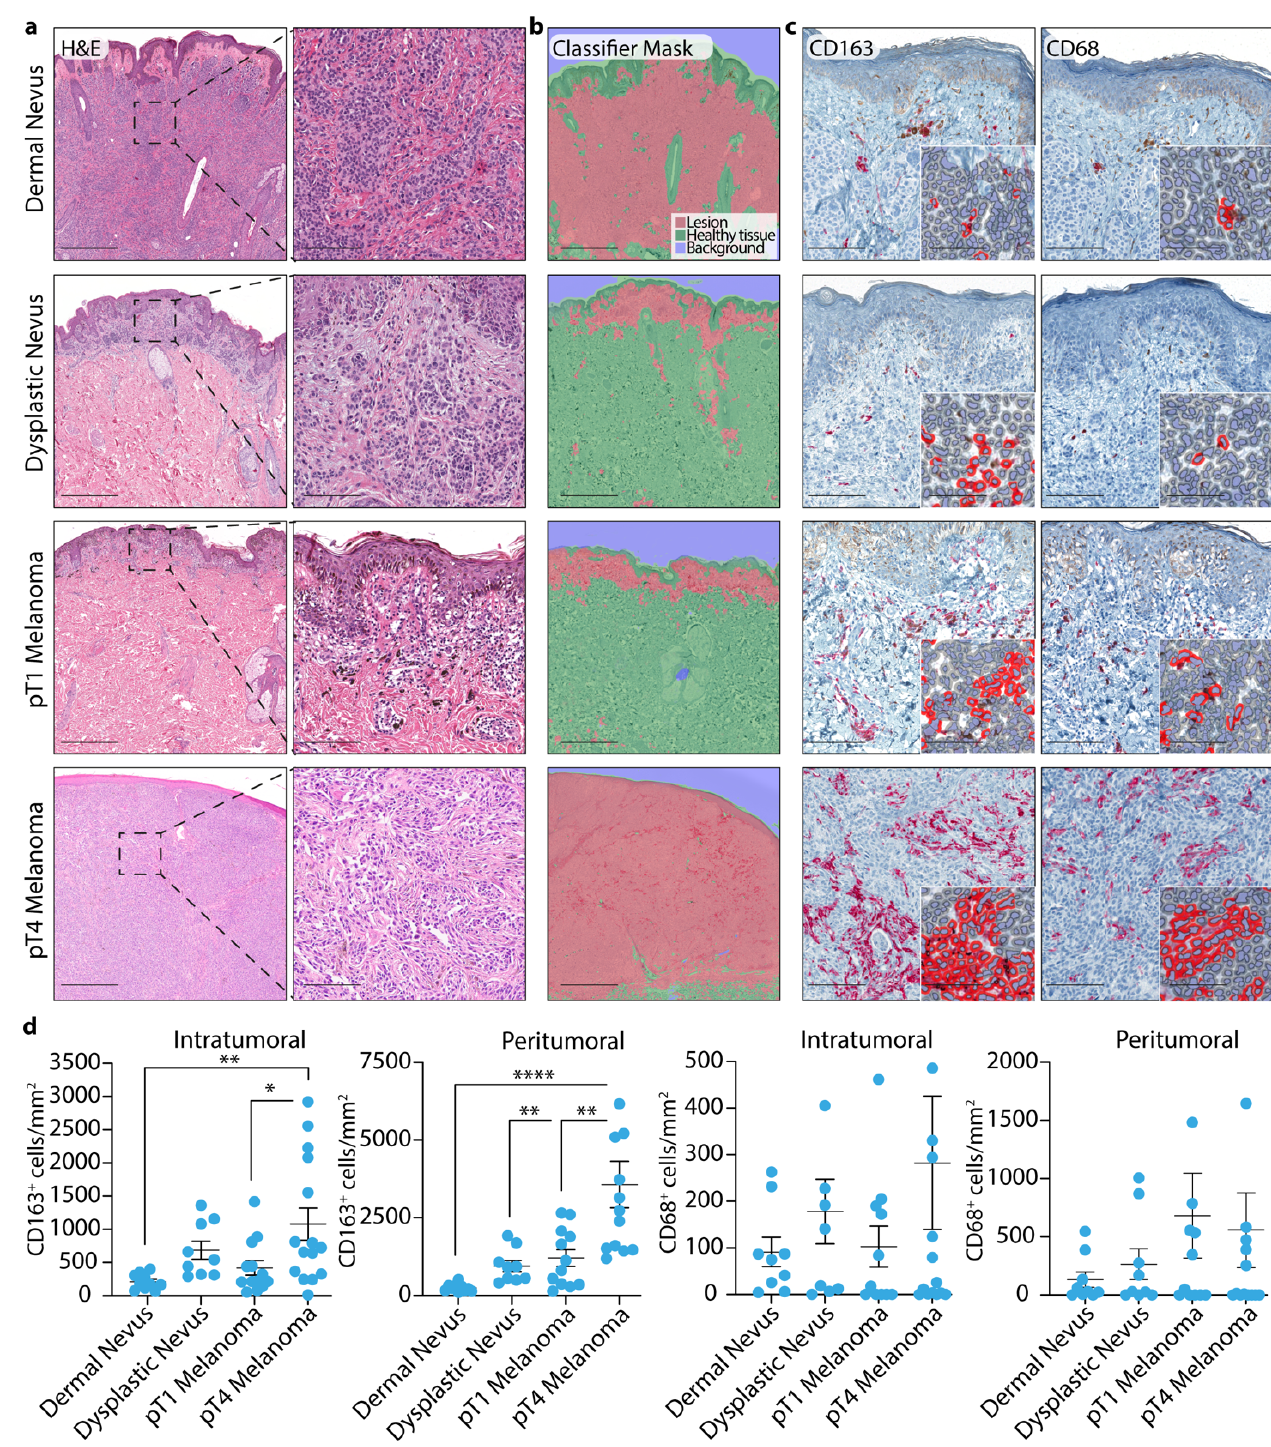
Figure 1. Digital quantification of CD163+ve and CD68+ve cells in dermal and dysplastic nevi and melanoma tissues. ( a ) Representative images of hematoxylin and eosin (H&E) staining in dermal and dysplastic nevus and pT1 and pT4 melanoma tissues. Scale bar represents 500 μ m and 100 μ m. ( b ) Representative images of Halo artificial intelligence-AI ® automatic segmentation of a lesion, healthy tissue and background of dermal and dysplastic nevus and pT1 and pT4 melanoma tissues. Scale bar 500 μ m. ( c ) Representative images of intratumoral CD68+ve and CD163+ve cells with digital automatic quantification mask of positive cells (inset) and ( d ) pooled data of intratumoral and peritumoral CD68+ve and CD163+ve cells. Scale bar 500 μ m and 50 μ m (inset). * p < 0.05, ** p < 0.01 **** p < 0.0001, one-way ANOVA and Bonferroni post hoc test.